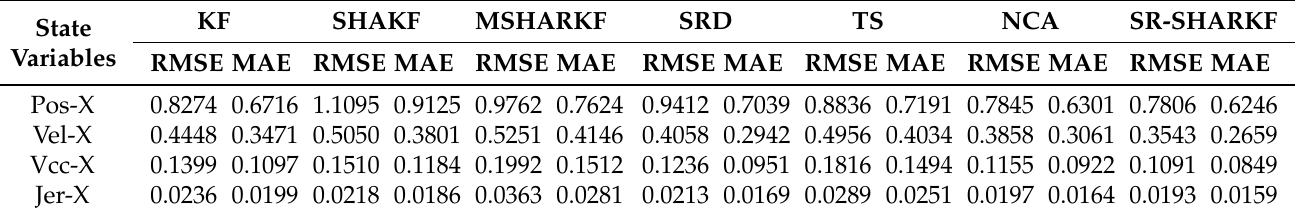
Table 1. Dynamic parameter error evaluation in the X-axis